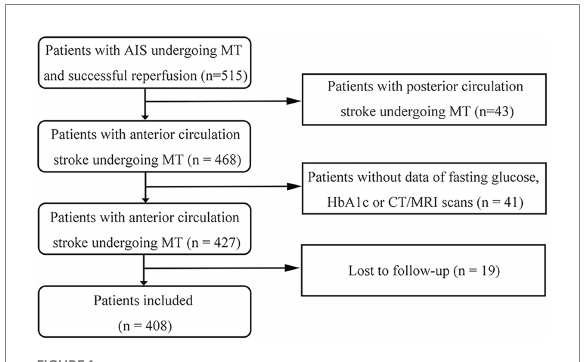
FIGURE 1 Flow diagram of the study. AIS, acute ischemic stroke; MT, mechanical thrombectomy; HbA1c, glycosylated